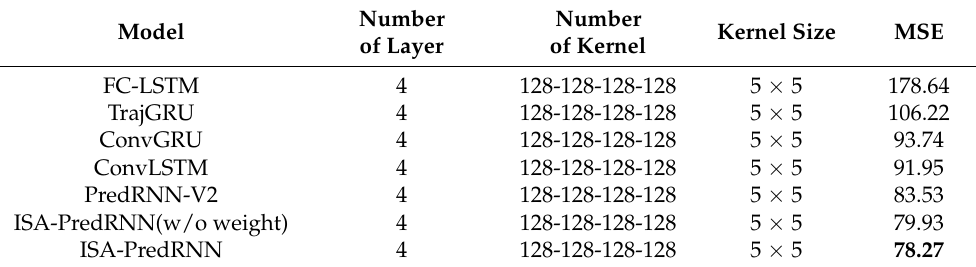
Table 4. Best mean square error (MSE) of seven models in the test